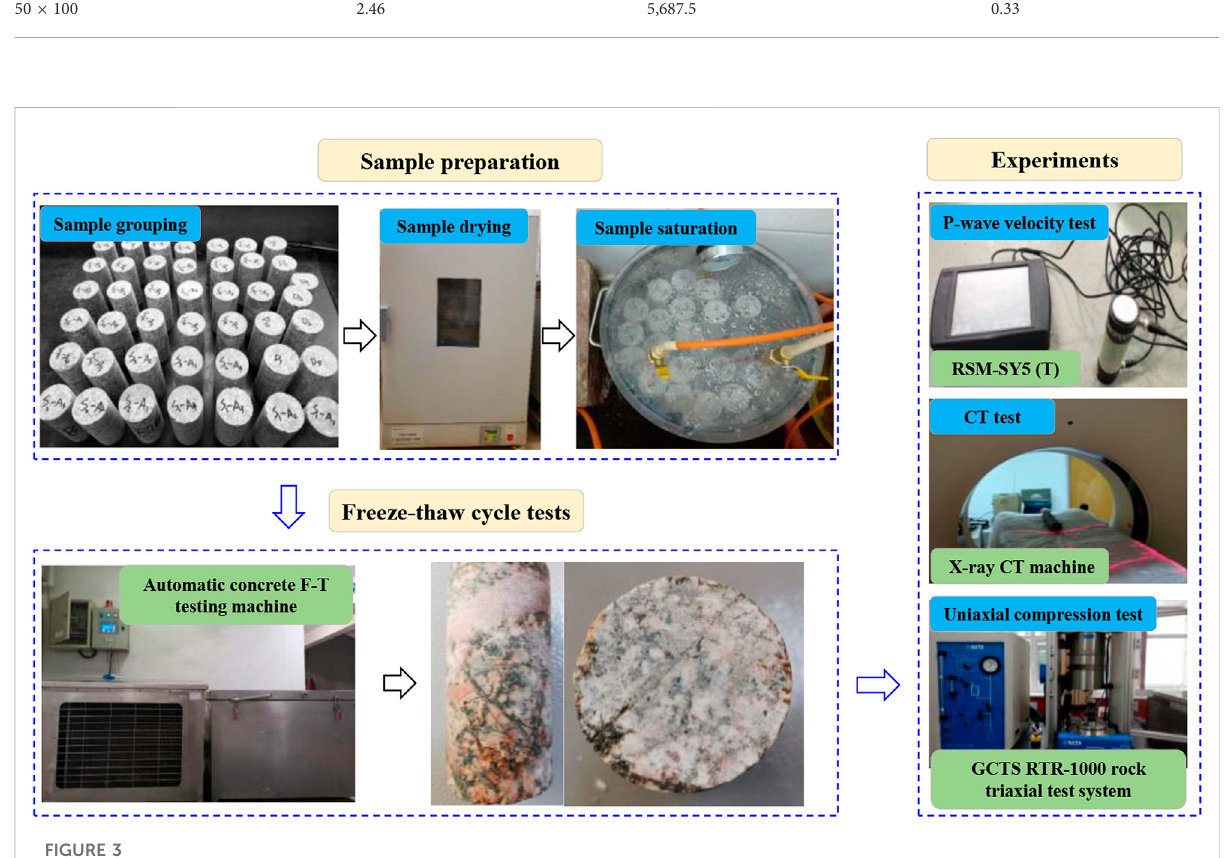
FIGURE 3 Test system and